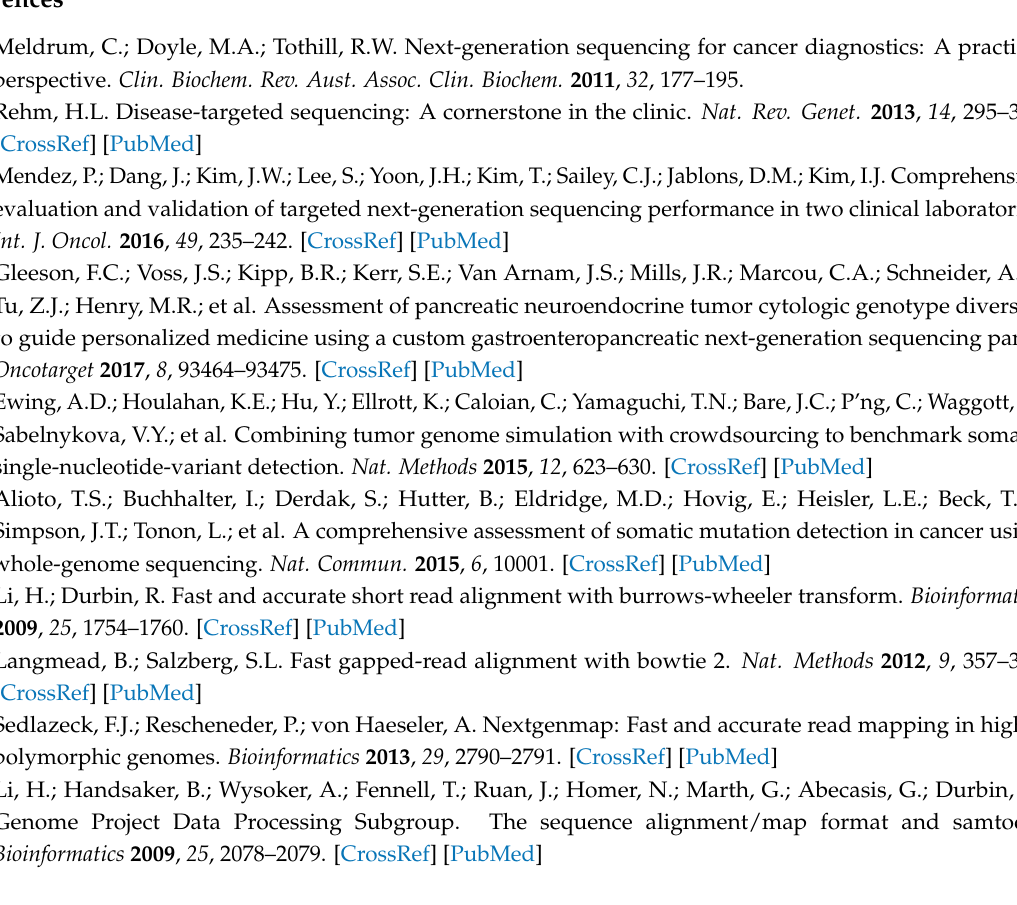
Table S1: Comparisons of variant calling results using VARIFI and Ion Reporter, Table S2: FP variants called in homopolymer regions—sample S 1 , Table S3: FP variants called in homopolymer regions—sample S 2 , Table S4: Validation of variants found with different confidence scores, Table S5: Amplicon coverage, Table S6: Example of a final report, File S1: An example of var and frmode